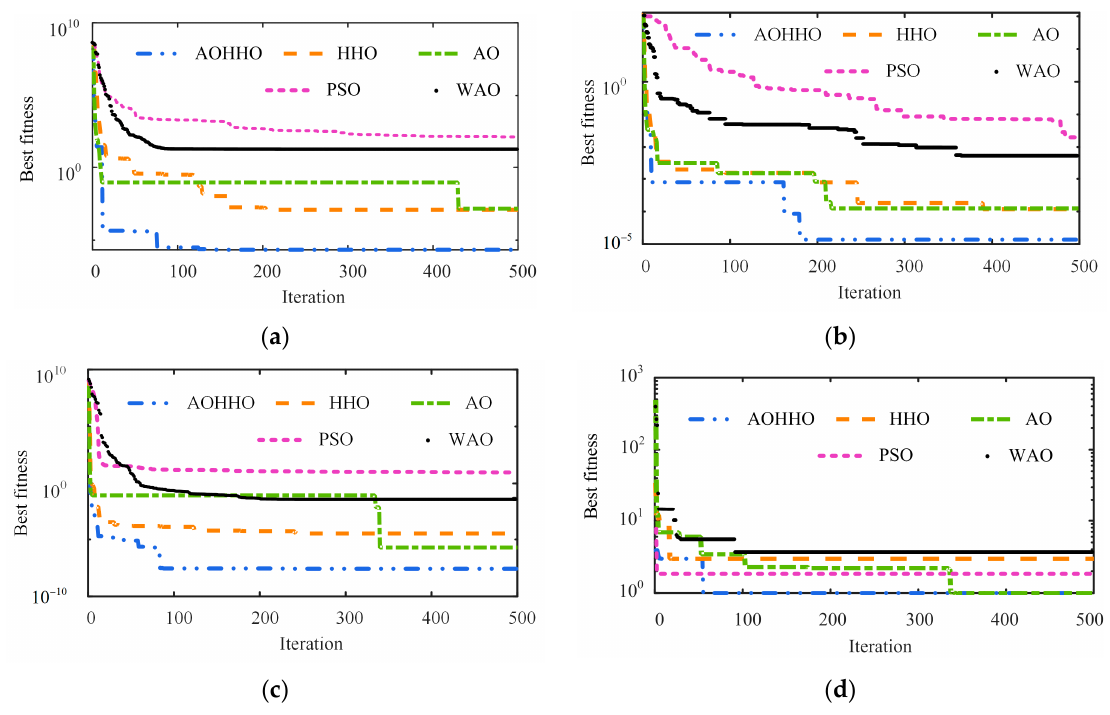
Figure 4. Iterative curves of each benchmark function: ( a ) F1; ( b ) F2; ( c ) F3; ( d ) F4.